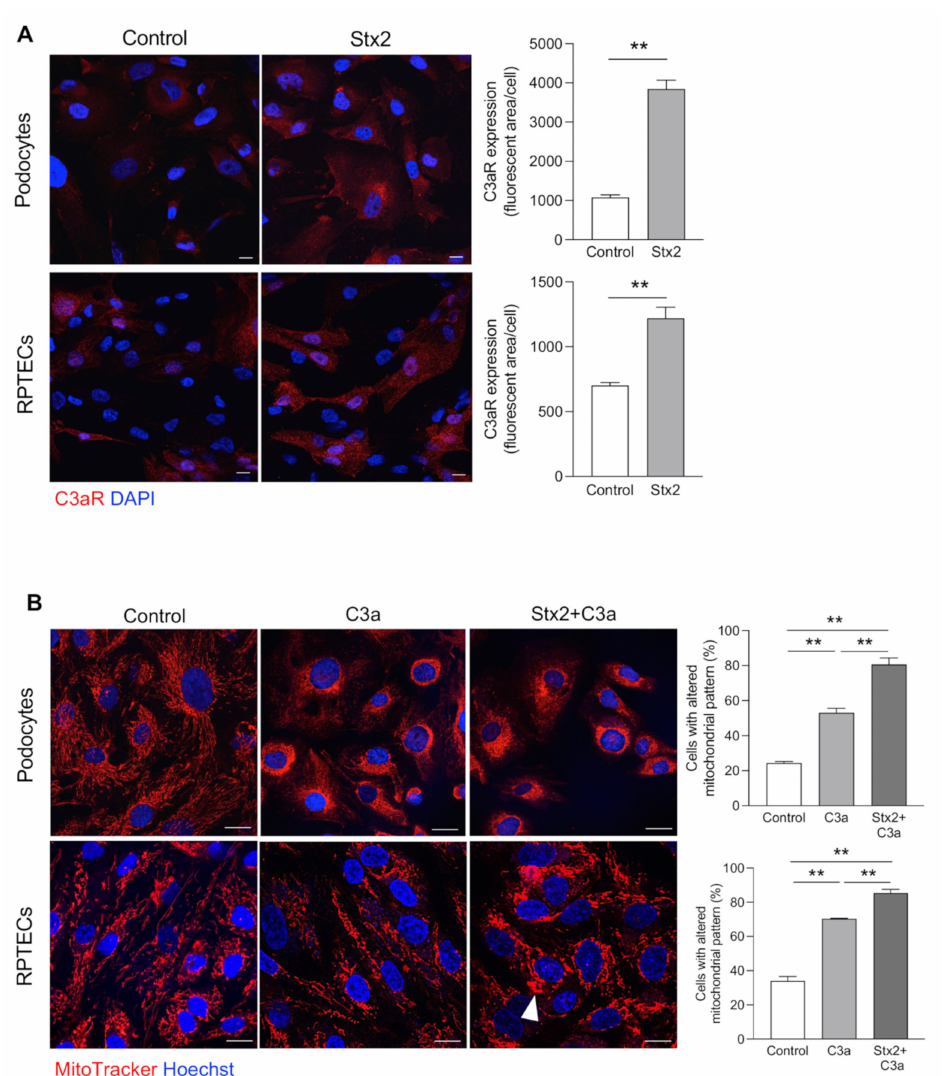
Figure 6. Stx2 increases podocyte and tubular cell sensitivity to C3a through the upregulation of C3aR expression in vitro. ( A ) Representative images and quantification of C3aR staining (red) in podocytes and RPTECs exposed to control medium or Stx2 (50 pM) for 15 h. Nuclei were counterstained with DAPI (blue). Scale bars: 20 µ m. Results are presented as mean ± SEM (number of biological